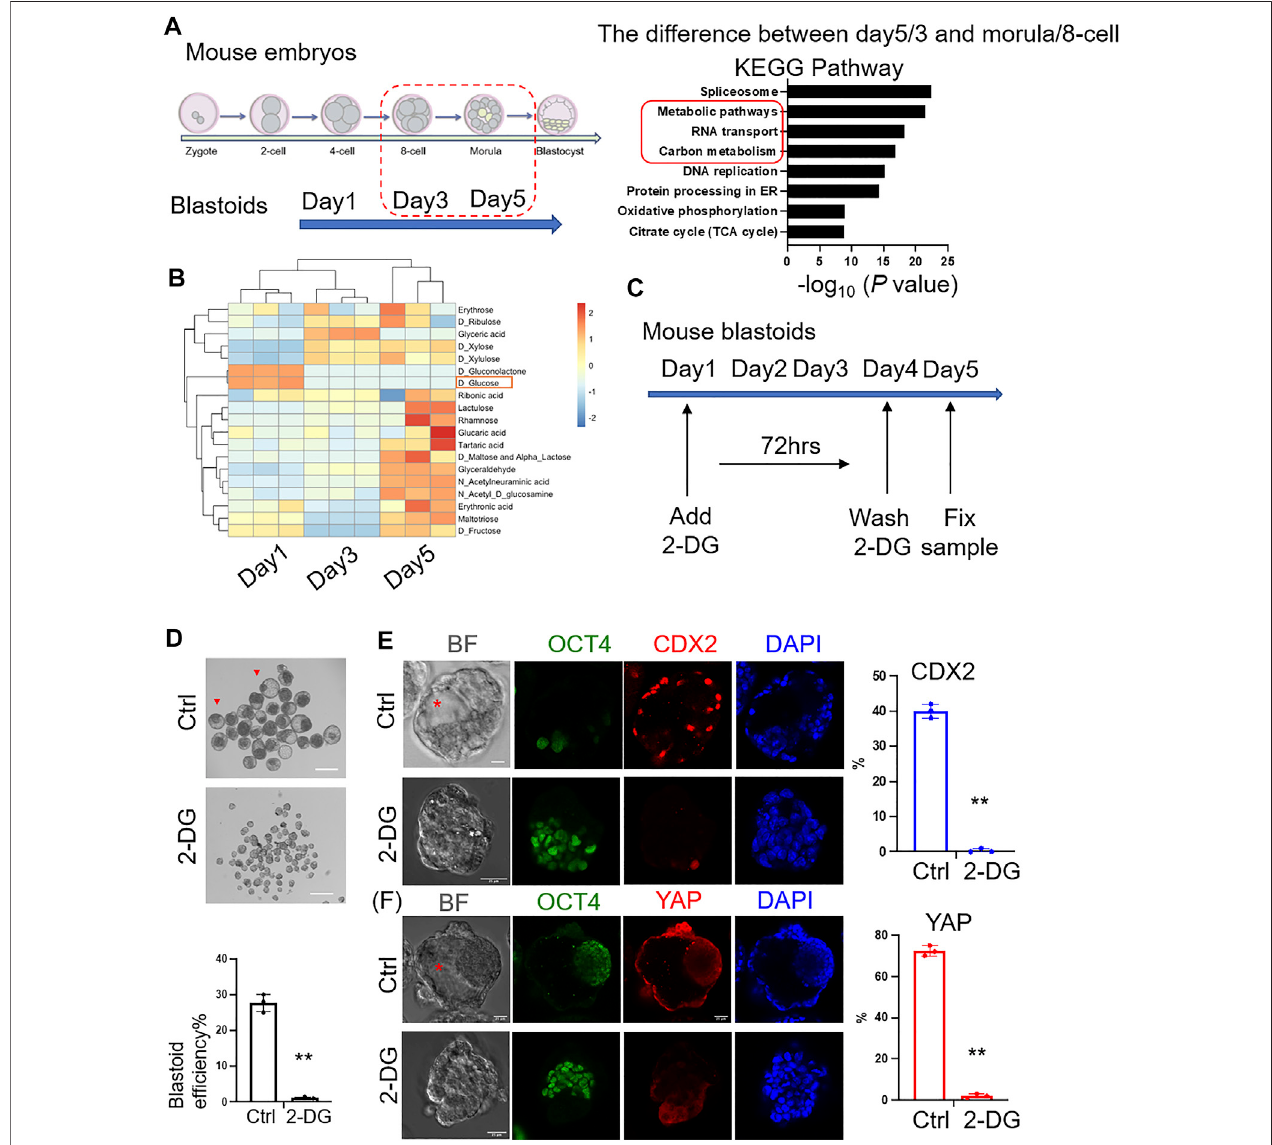
FIGURE 2 | Importance of glucose metabolism to the formation of mouse blastoids. (A) KEGG analysis of differentially expressed proteins between blastoids and mouse embryosattheindicatedstages. (B) MetabolitesofblastoidsandculturedmediumofblastoidsatDays1,3and5. (C) EPSaggregatesculturedincontroland2-DGmedium.2-DG was added to the medium on Day 1 and washed off on Day 4 (~72 h). (D) Phase-contrast images of EPS aggregates after 5 days of blastoid culture medium supplemented with vehicle (top) and 2-DG (down). The quanti fi cation of blastoid formation ef fi ciency with the indicated treatment was performed. Scale bar = 150 μ m **, p ＜ .01. (E) Immuno fl uorescencestainingofEPSaggregatesofthecontroland2-DG-treatedgroupsatDay5forCDX2expression.Scalebar=25 μ m**, p ＜ .01.Redasteriskindicatescavity. (F) Immuno fl uorescence staining of EPS aggregates of the control and 2-DG-treated groups at Day 5 for YAP expression. Scale bar = 25 μ m **, p ＜ .01. Red asterisk indicates cavity.